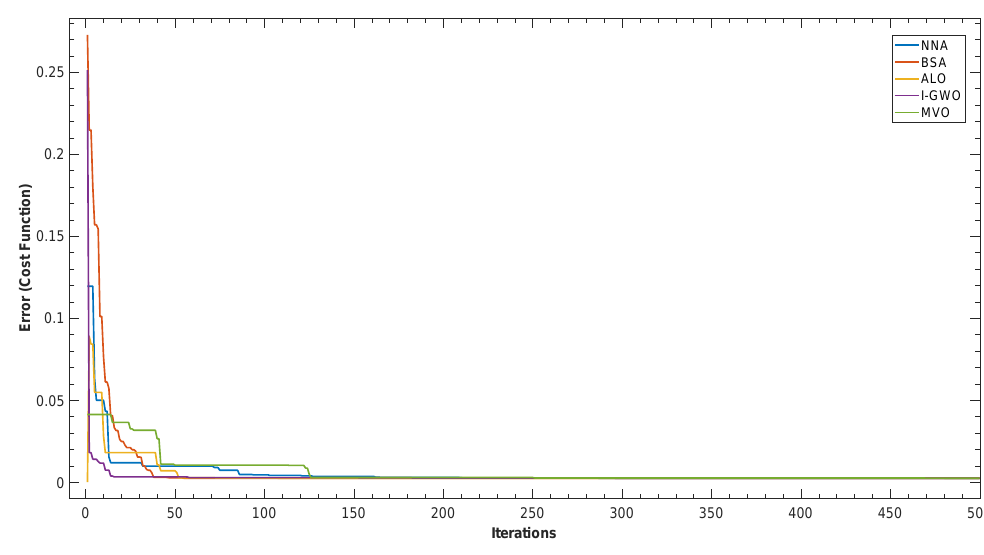
Figure 4. Convergence curves for the trained OAs, considering 100% RH. Next, Figures 5–9 show the prediction curves for the best OA, i.e., in this case NNA, at different RH values.